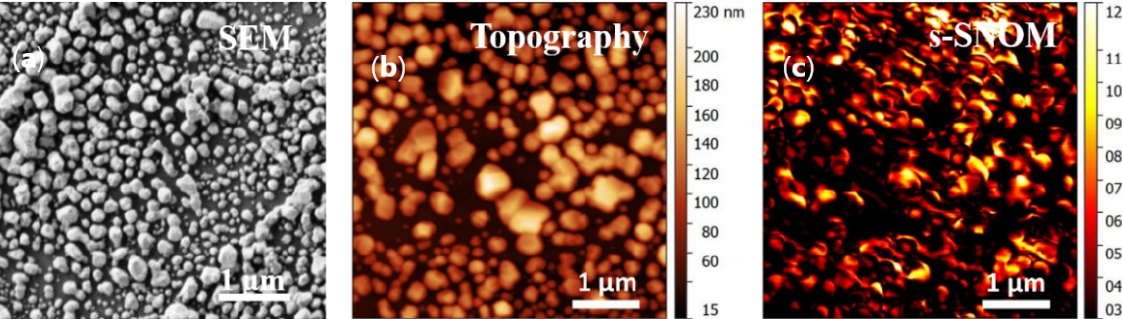
Figure 2. Characterization of plasmonic nanostructured surfaces. ( a ) SEM image of AgNSS; ( b ) topographical (AFM) image of AgNSS aggregates; ( c ) typical pseudo-color s-SNOM image (5 × 5 µ m 2 ) of Ag nanoparticles obtained at the wavelength λ = 720 nm. The color scale ( c ) shows the optical near-field intensity in arbitrary units.